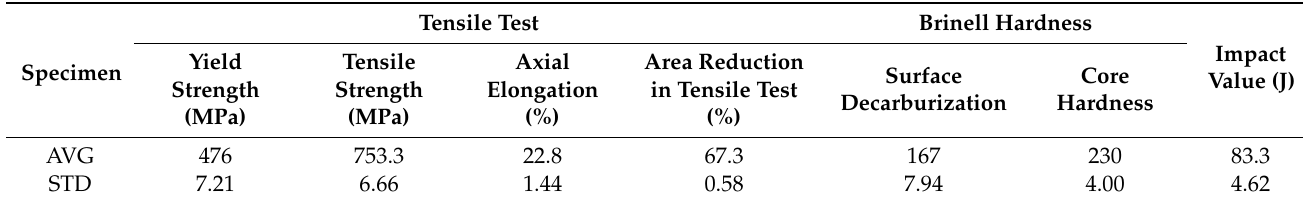
Table 3. Gearbox boom mechanical properties test